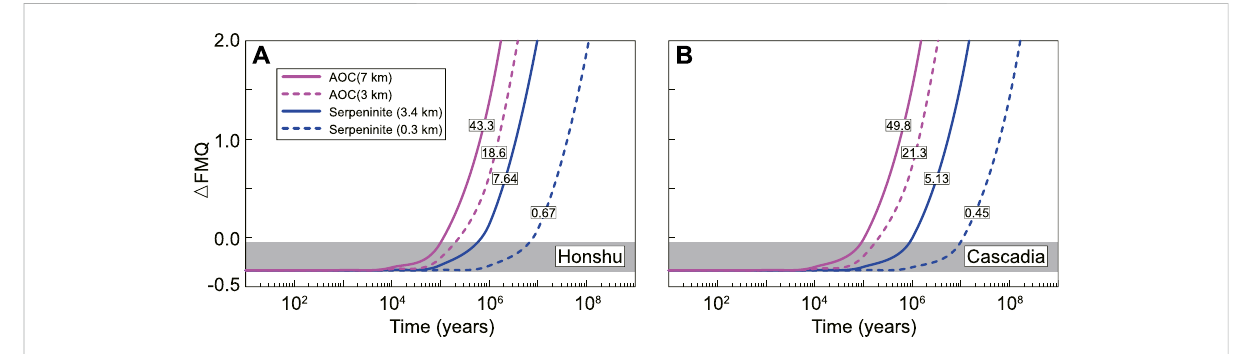
FIGURE 5 Calculatedevolutionofmantlelog f O 2 relativetoFMQwithtimefortheoxidation fl uxinputfromsubductedAOC( (A) ,cold)andserpentinite( (B) , blue)intheopensystem.Greyboxistheinitialmantle f O 2 .ThenumbersinboxrepresentC-andS-relatedoxidation fl uxes(×10 12 mol/year)released by subducted slab. Different layer thicknesses of AOC and serpentinite are after White and Klein. (2014) and Evans (2012), respectively.